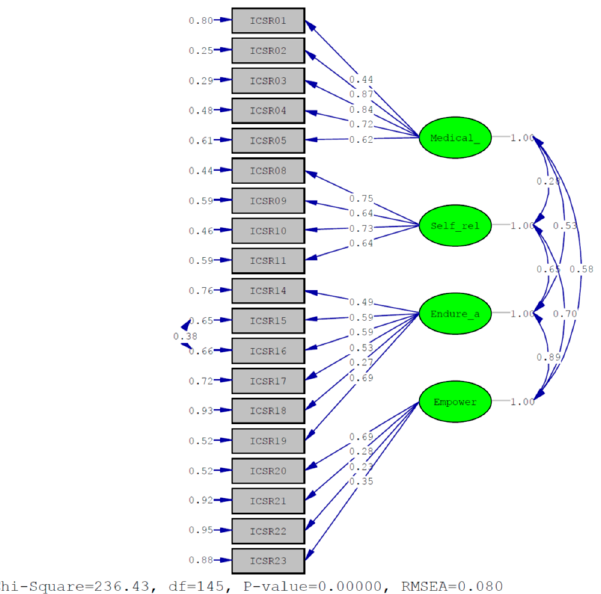
Figure 2. Four-factor model of the ICSR. Notes: Medical: seeking medical help; Self_rel: self-relieving of discomforts; Endure_a: making efforts to endure and adjust; Empower: enabling self-help for empowerment.